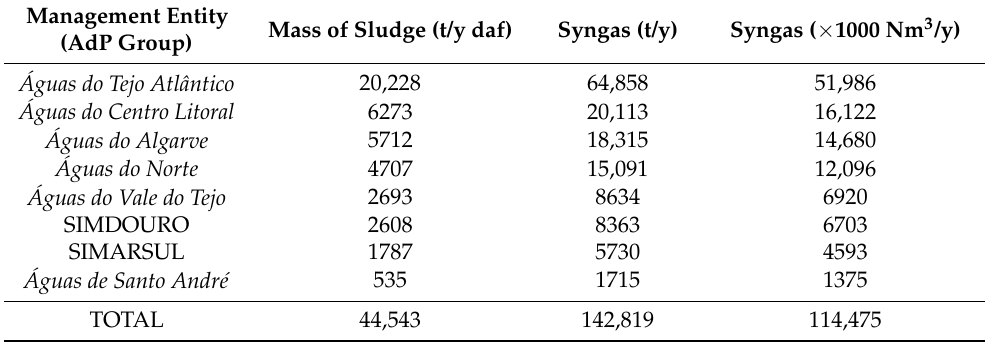
Table 3. Estimated syngas amounts obtained from dewatered-sludge gasification for each managing entity (AdP